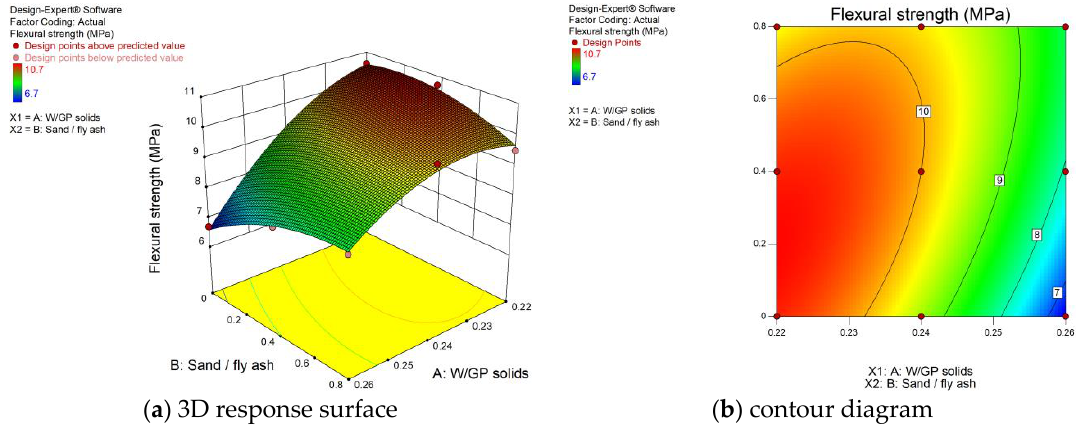
Figure 8. Flexural strength versus W/GP solids and sand/fly ash . ( a ) 3D response surface, ( b ) contour diagram.